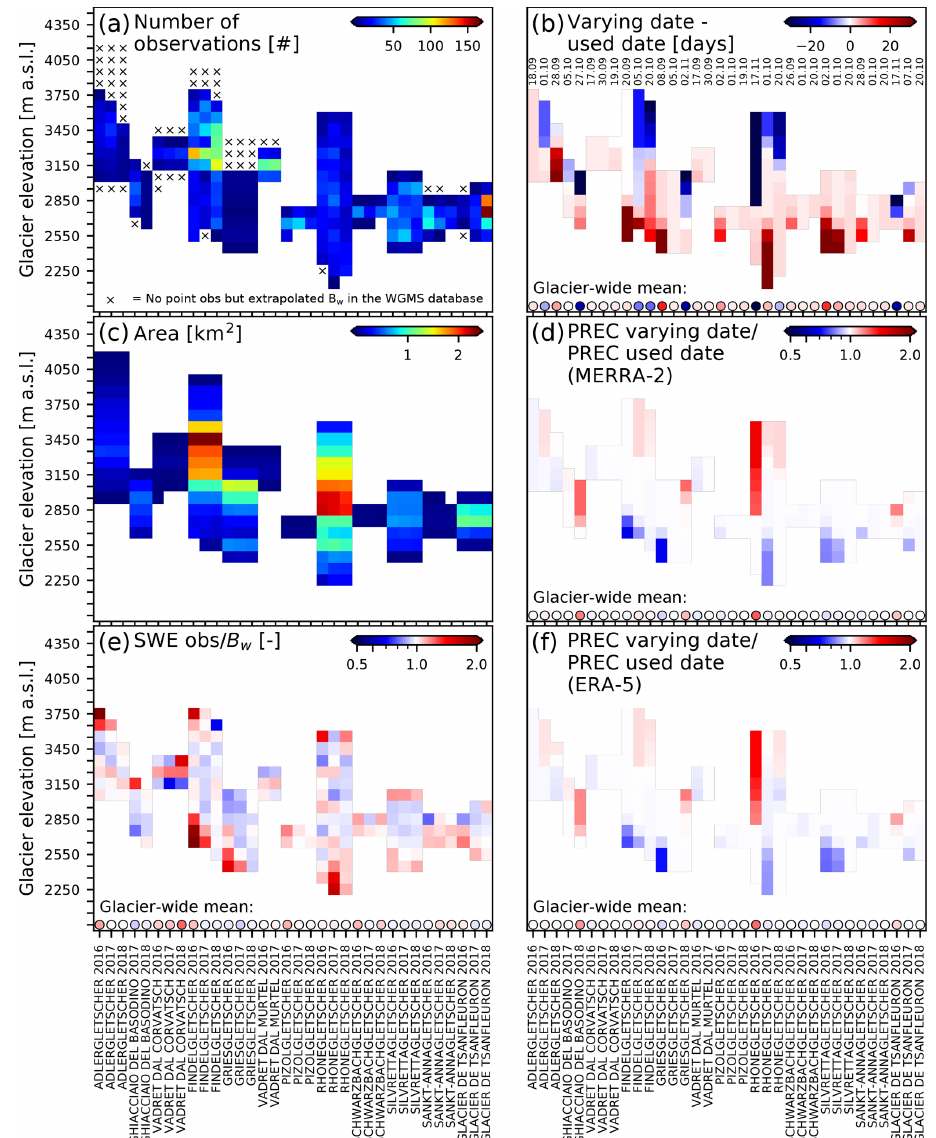
Figure 9. Sensitivity analysis of extrapolated B w data and used starting dates for 12 glaciers in the Swiss Alps between 2016 and 2018 (GLAMOS, 2021). (a, c, e) Difference between B w data used in this study and point-SWE observations: (a) number of manual observations performed in the elevation intervals of the glaciers. (c) Area of the glacier according to the elevation interval. (e) Ratio between the observed SWE and the B w data. (b, d, f) Impact of the date considered the beginning of the accumulation season on seasonal precipitation totals: (b) differences between accurate (varying) dates of the beginning of the accumulation period and the used dates in the study (the day and the month of the used dates are written on the figure (DD.MM)). (d) Ratio between the total precipitation of MERRA-2 according to the accurate dates and the used dates. (f) Ratio between the total precipitation of ERA5 according to the accurate dates and the used